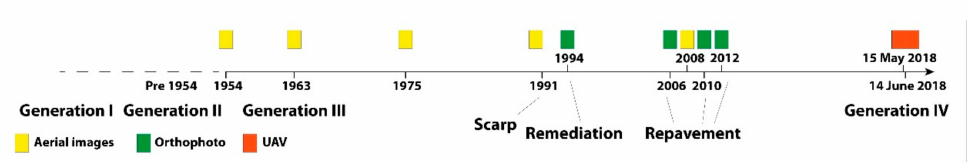
Figure 12. Time line of the Champlas du Col landslide evolution from 1954 to 2018.